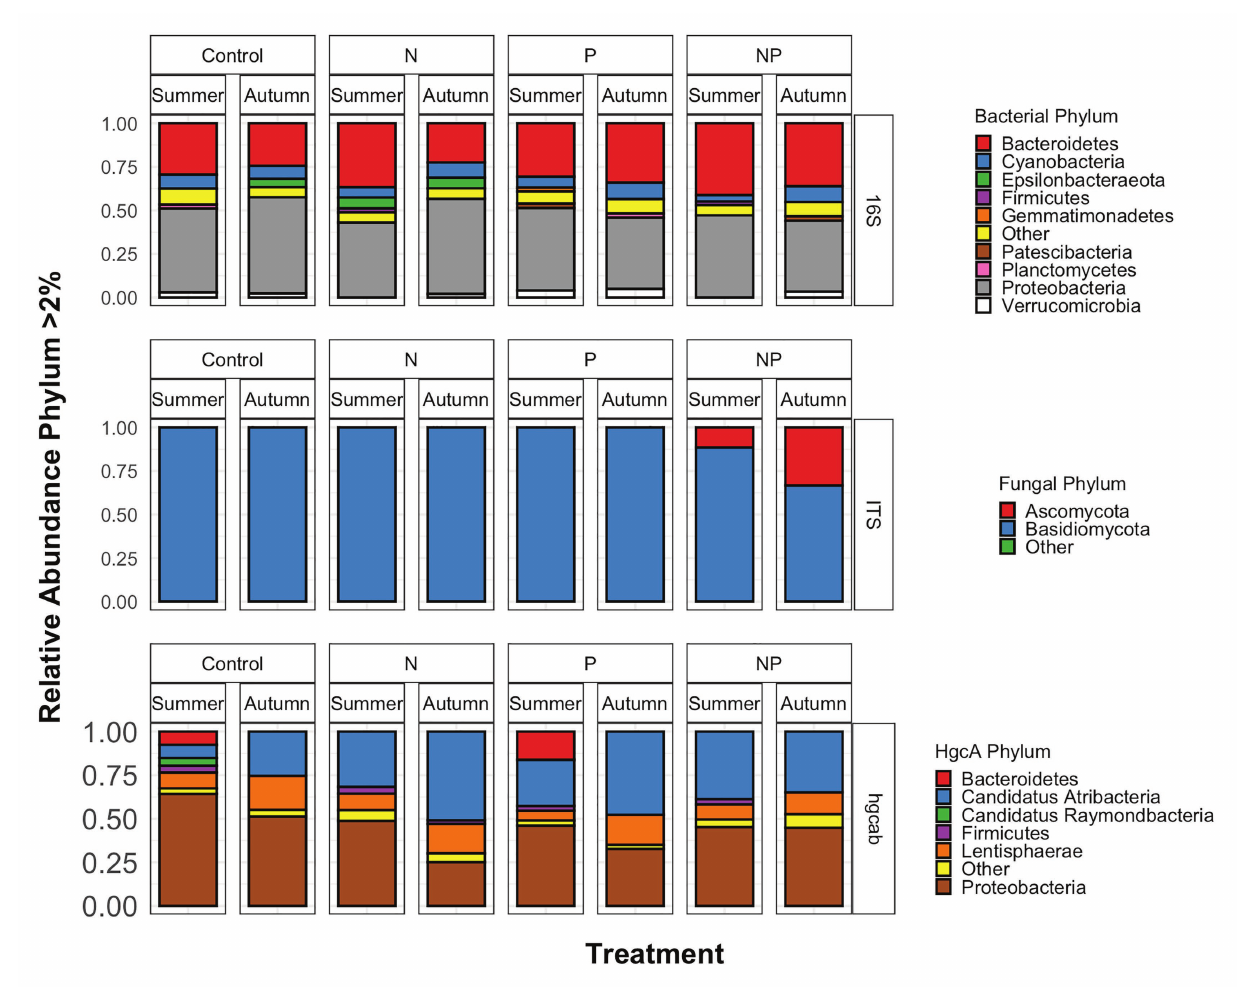
FIGURE 3 | Phyla relative abundances of bacterial/archaeal (16S rRNA), fungal (ITS), and mercury methylating ( hgcAB ) microbial communities of control, nitrate (N), phosphate (P), and nitrate + phosphate (NP) nutrient exposures in summer and autumn